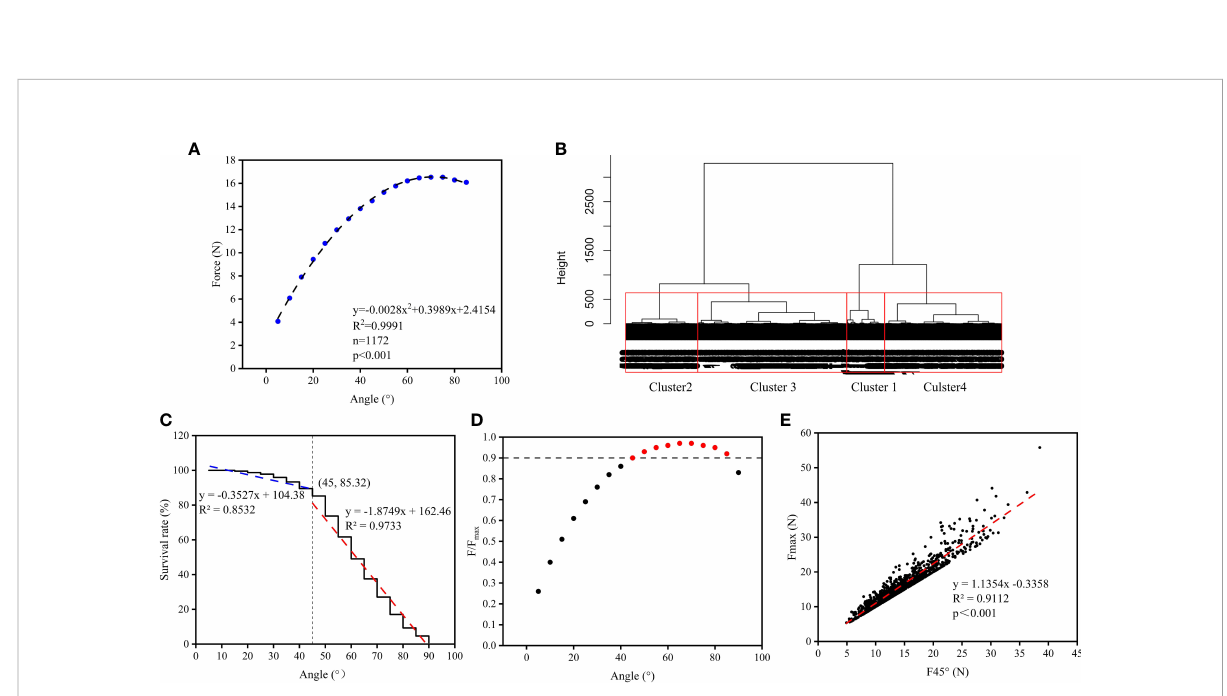
FIGURE 5 The data analysis of lodging resistance from maize plants at different locations in three years. (A) Stress values of maize plants at different angles. (B) Clustered lodging level of maize plants according to the tested F max . (C) The survival rate of maize plants under different tilted angles. (D) The ratio of F to F max under different tilted angles. (E) Correlation between F 45 and F max .